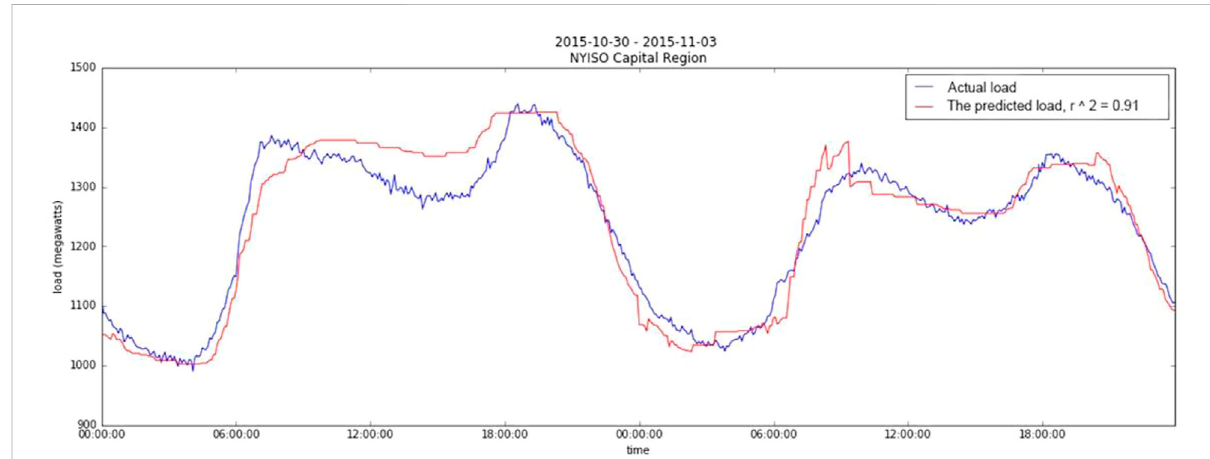
FIGURE 7 The forecasted EEC from the end of October 2015 to the beginning of November 2015.